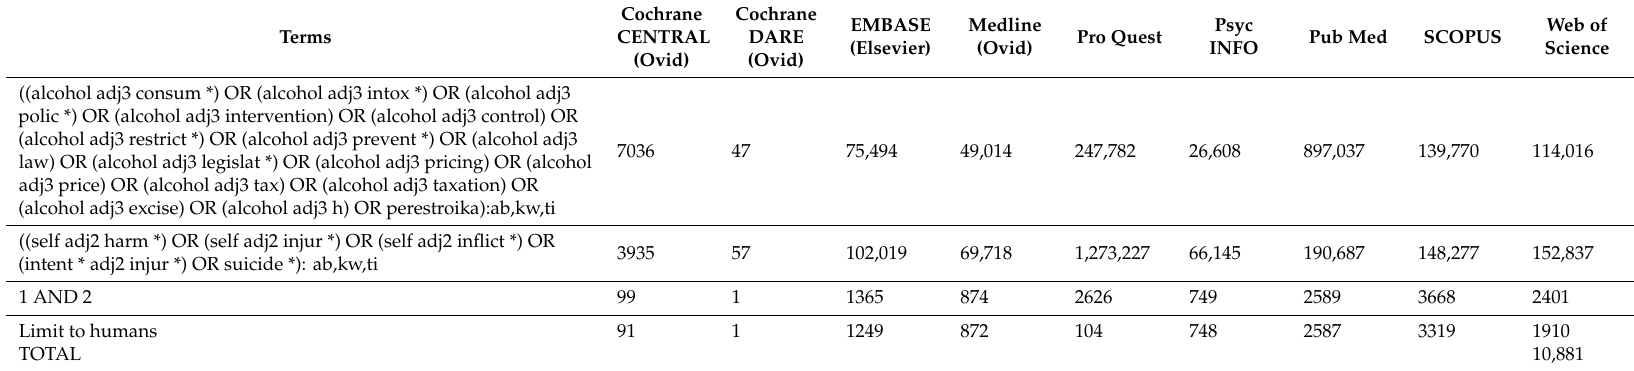
Table 1. Electronic search strategy used in di ff erent databases for the present